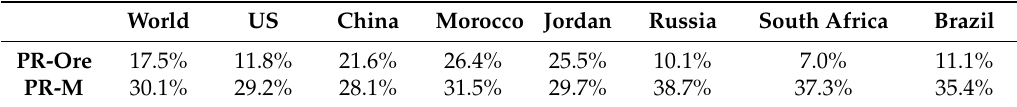
Table 1. Average grades of in situ ore (PR-Ore) and marketable concentrate (PR-M) in % P 2 O 5 (columns 3 to 6 = mainly sedimentary ore, columns 7 to 9 = mainly igneous ore) based on [6]. World US China Morocco Jordan Russia South Africa Brazil